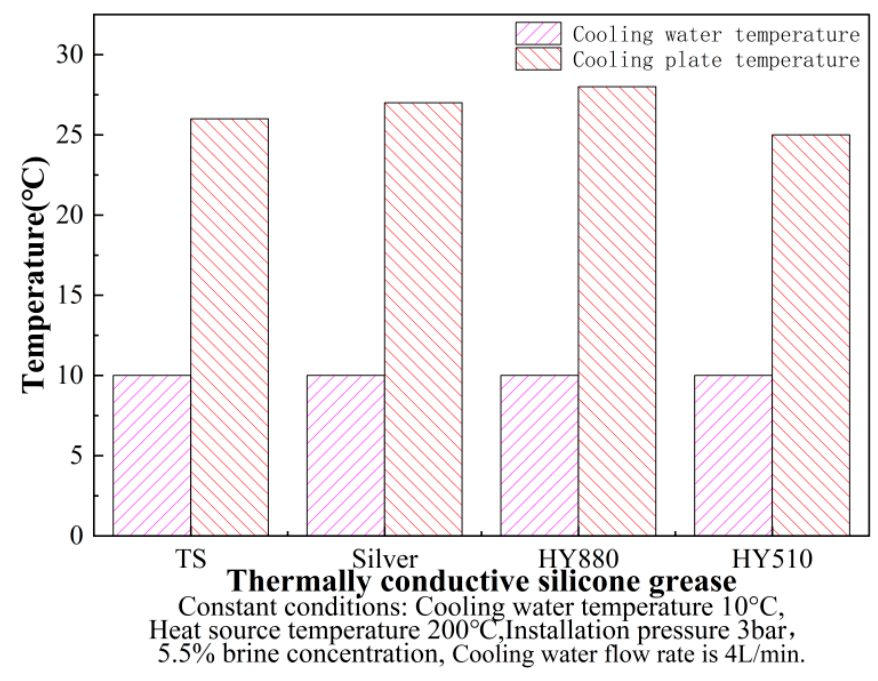
Figure 6. Effect of different thermally conductive silicone greases on cooling plate temperature.